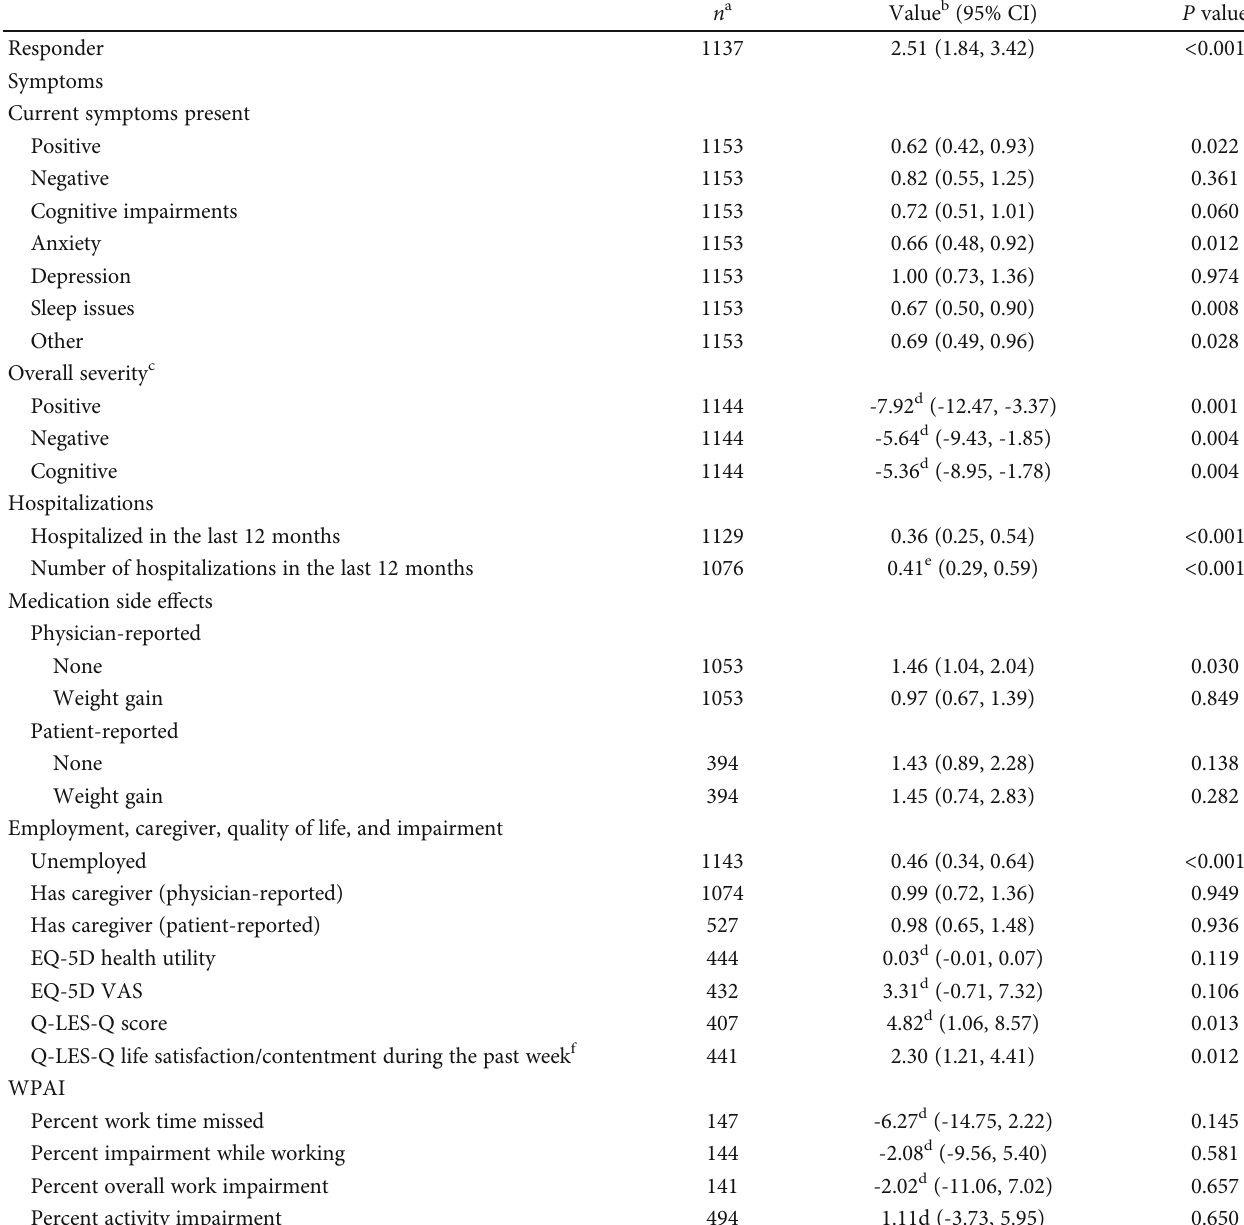
Table 4: Multivariate regression